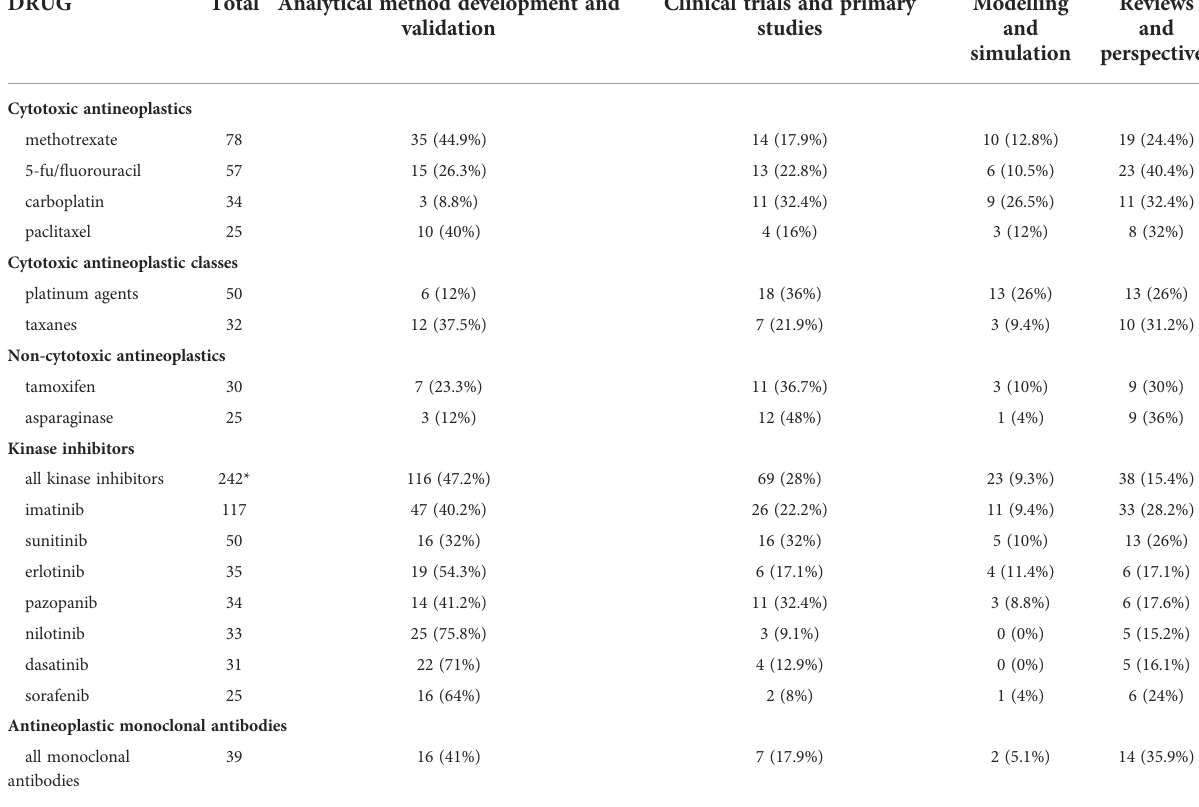
TABLE 1 Publication type identi fi ed for the most commonly reported cytotoxic and non-cytotoxic antineoplastics (25 reports or